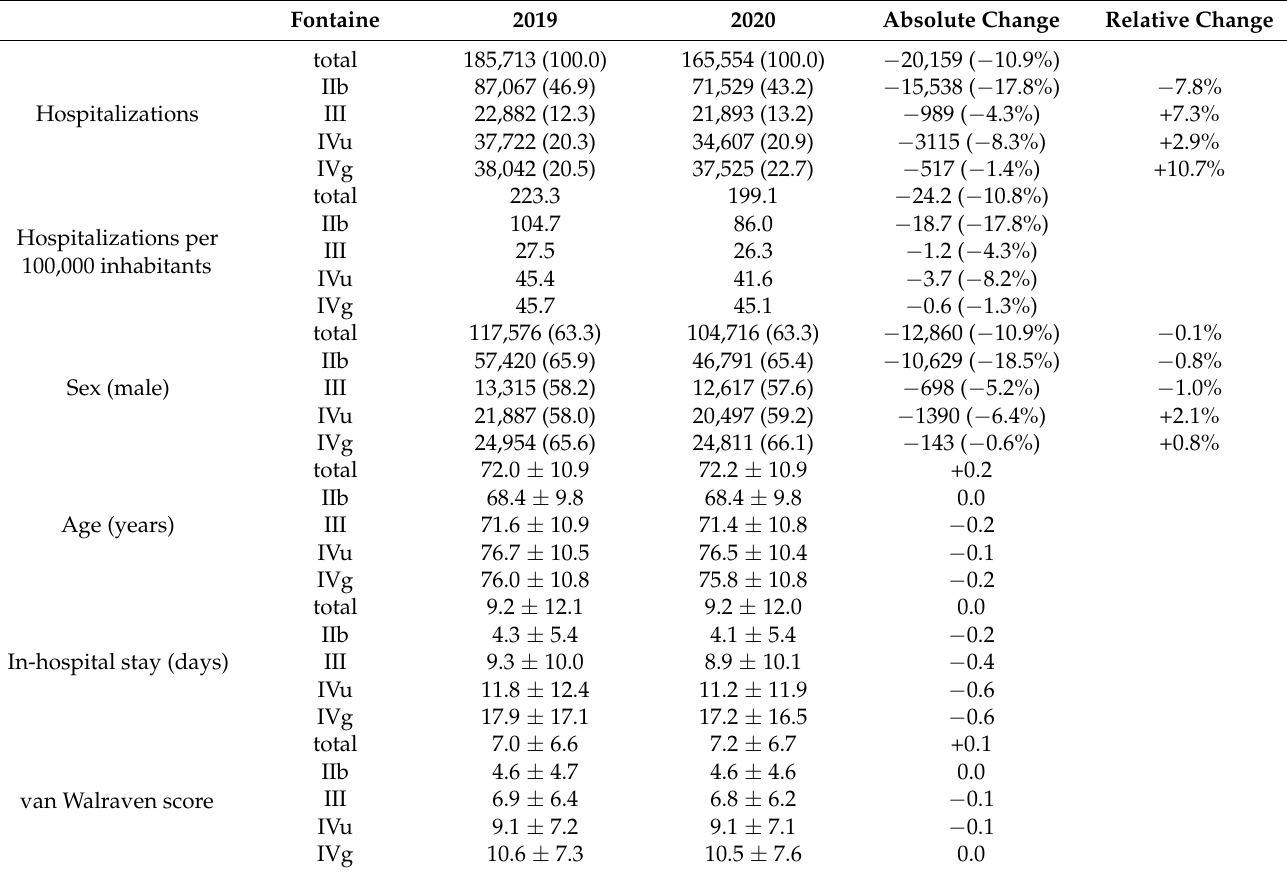
Table 1. Baseline characteristics of patients hospitalized due to peripheral artery disease in 2019 and